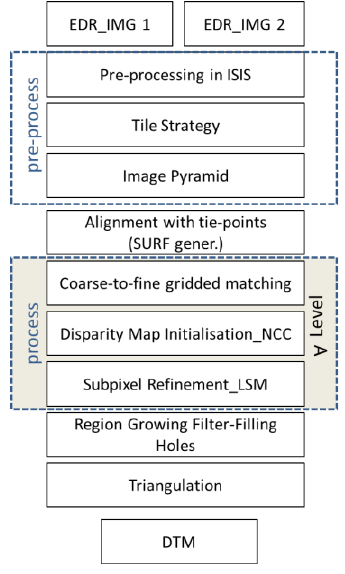
Figure 1: Workflow of DM for Planetary